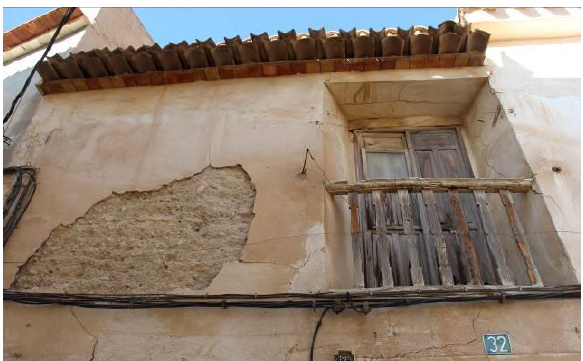
Figure 7. Simple rammed earth wall rendered with gypsum (Source: authors).